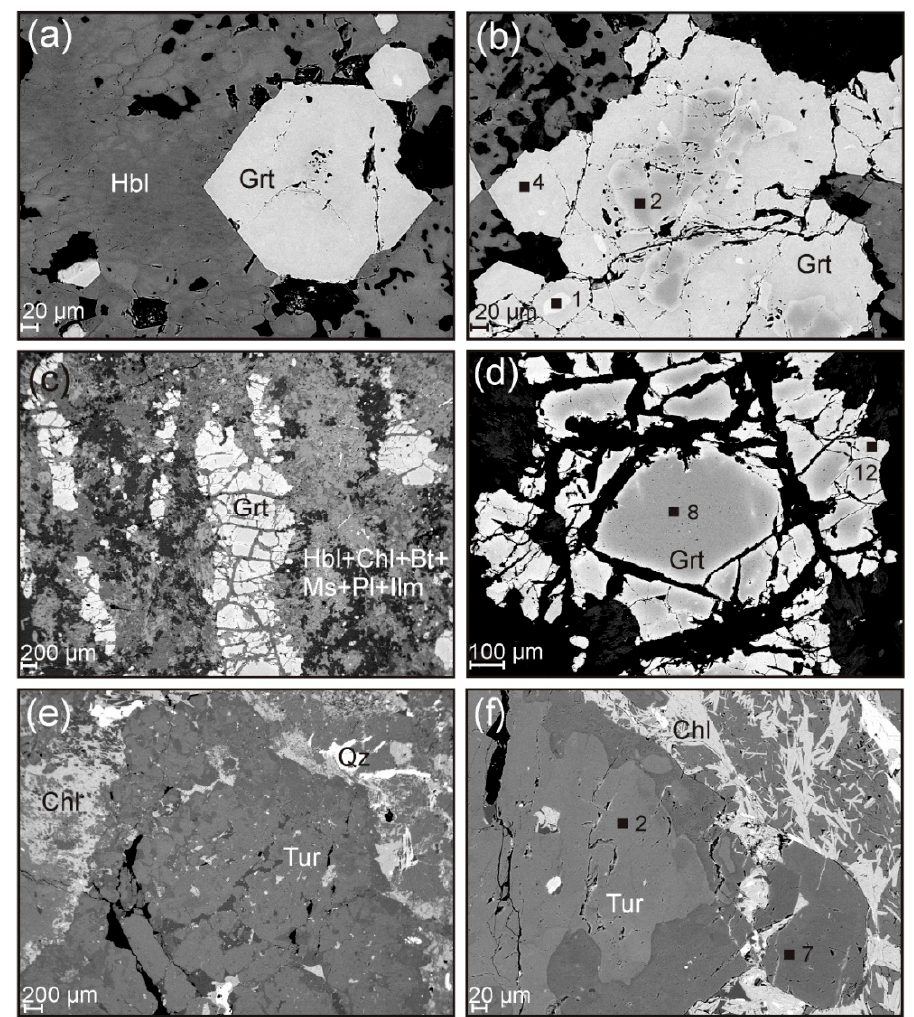
Figure 8. Garnet and tourmaline in the rocks from the DW block. ( a,b ) Garnet in garnet amphibolite, sample OK-6; ( c,d ) garnet from schlierens in diorite-gneiss, sample OK-7; ( e,f ) and tourmaline from schlierens in diorite-gneiss, sample OK-8. Back-scattered electron (BSE) images. Black squares indicate the points of microprobe analysis. Microprobe analysis point numbers correspond to the numbers in Table 3 (tourmaline) and Table 5 (garnet). Grt—garnet, Hbl—hornblende, Chl—chlorite,